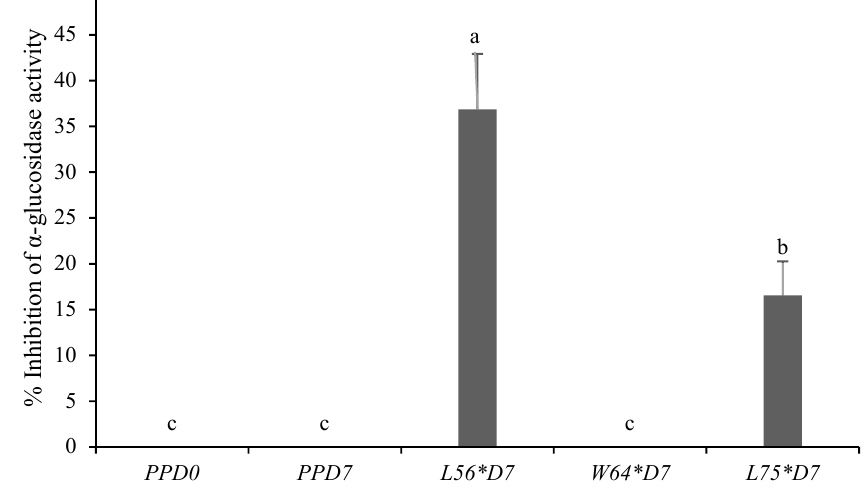
Figure 3. Inhibition of α -glucosidase activity of ½ diluted papaya puree fermented with different LAB strains. Bars with the same letter are not significantly different at p < 0.05.